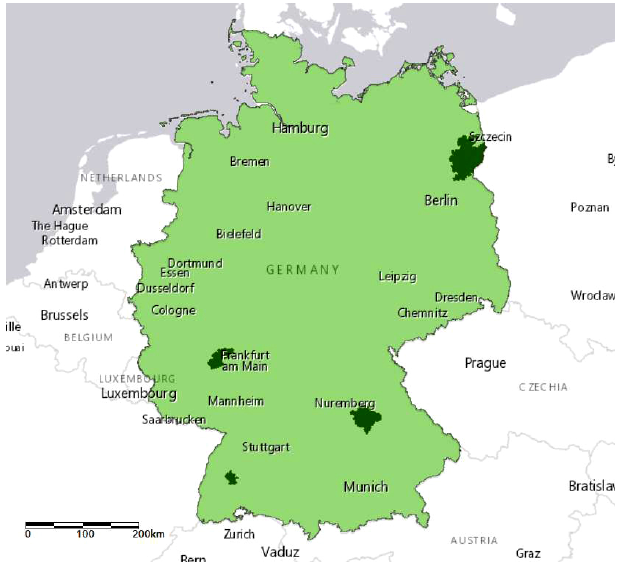
Fig. 1. Management areas of the Uckermark-Schorfheide (in the north-east part of Germany), Neumarkt, Middle Black Forest, and Rheingau-Taunus landcare associations,